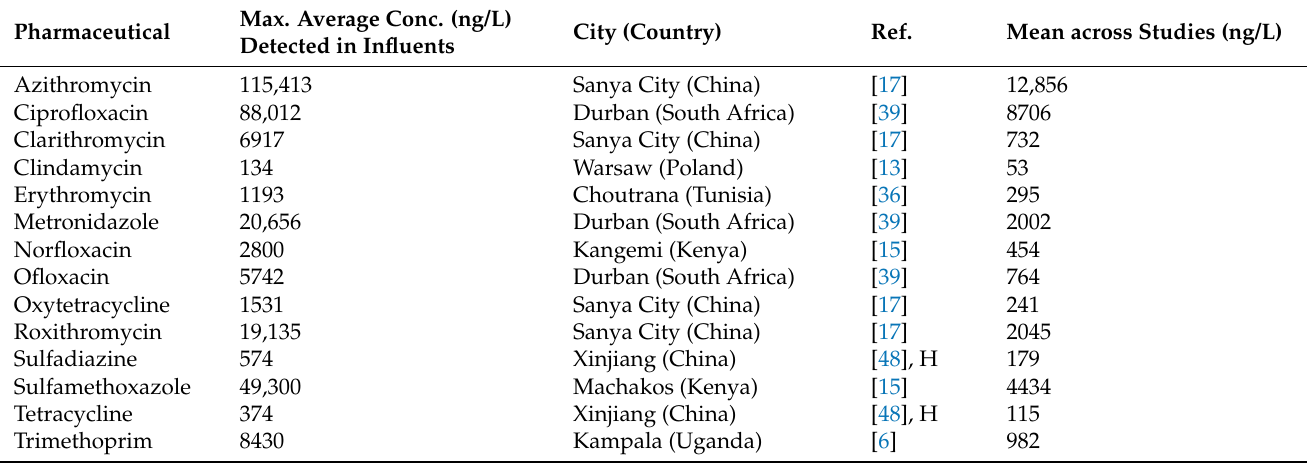
Figure 4. Sixteen different classes of PRs detected among studies. The influent concentration of the most common PRs occurring in 46 WWTPs was investigated (Table 4). Only compounds shared in more than four studies (out of fourteen) were considered in this analysis. It should be pointed out that a constraint in this comparative study lies in that the studies dealt with different limits of quantification. Table 4. Max average concentrations and means (ng/L) of the PRs detected in more than a quarter of the studies in the influent of 46 WWTPs.